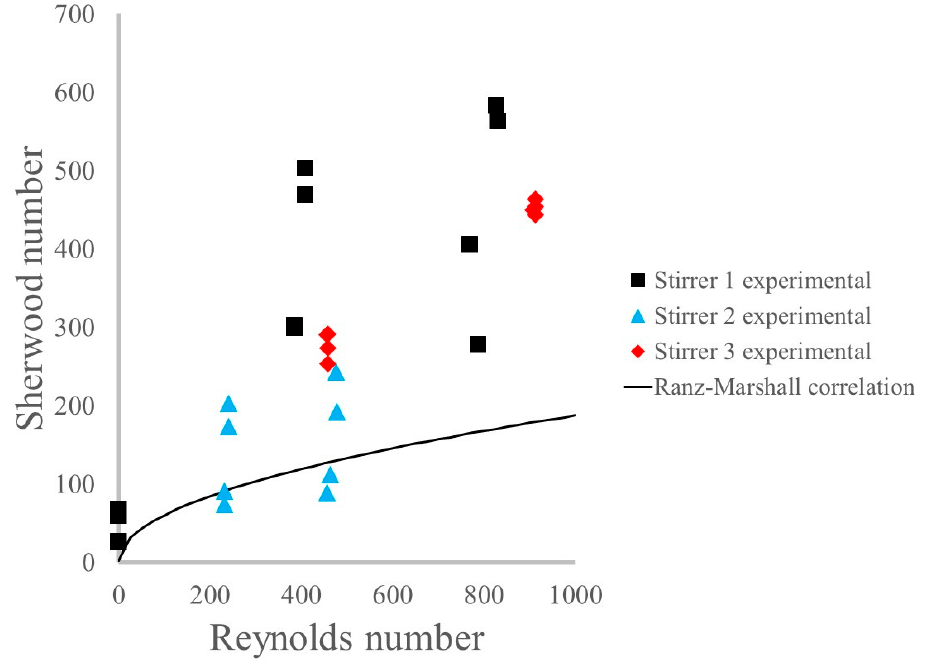
Figure 4. Sherwood number as a function of Reynolds number for beaker and stirrer apparatus.